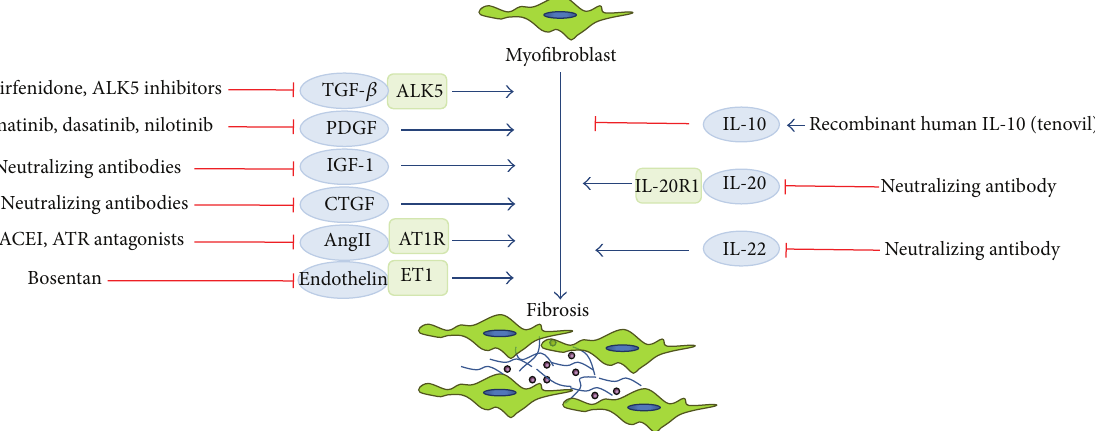
Figure 2: Potential therapeutic targets of fibrosis. ACEI: angiotensin-converting enzyme inhibitors; ALK5: activin-linked kinase 5; Ang II: angiotensin II; ATR: angiotensin receptor; CTGF: connective tissue growth factor; ET1: endothelin receptor isoform 1; IGF-1: insulin-like growth factor-1; IL: interleukin; PDGF: platelet-derived growth factor; TGF- 𝛽 : transforming growth factor- 𝛽